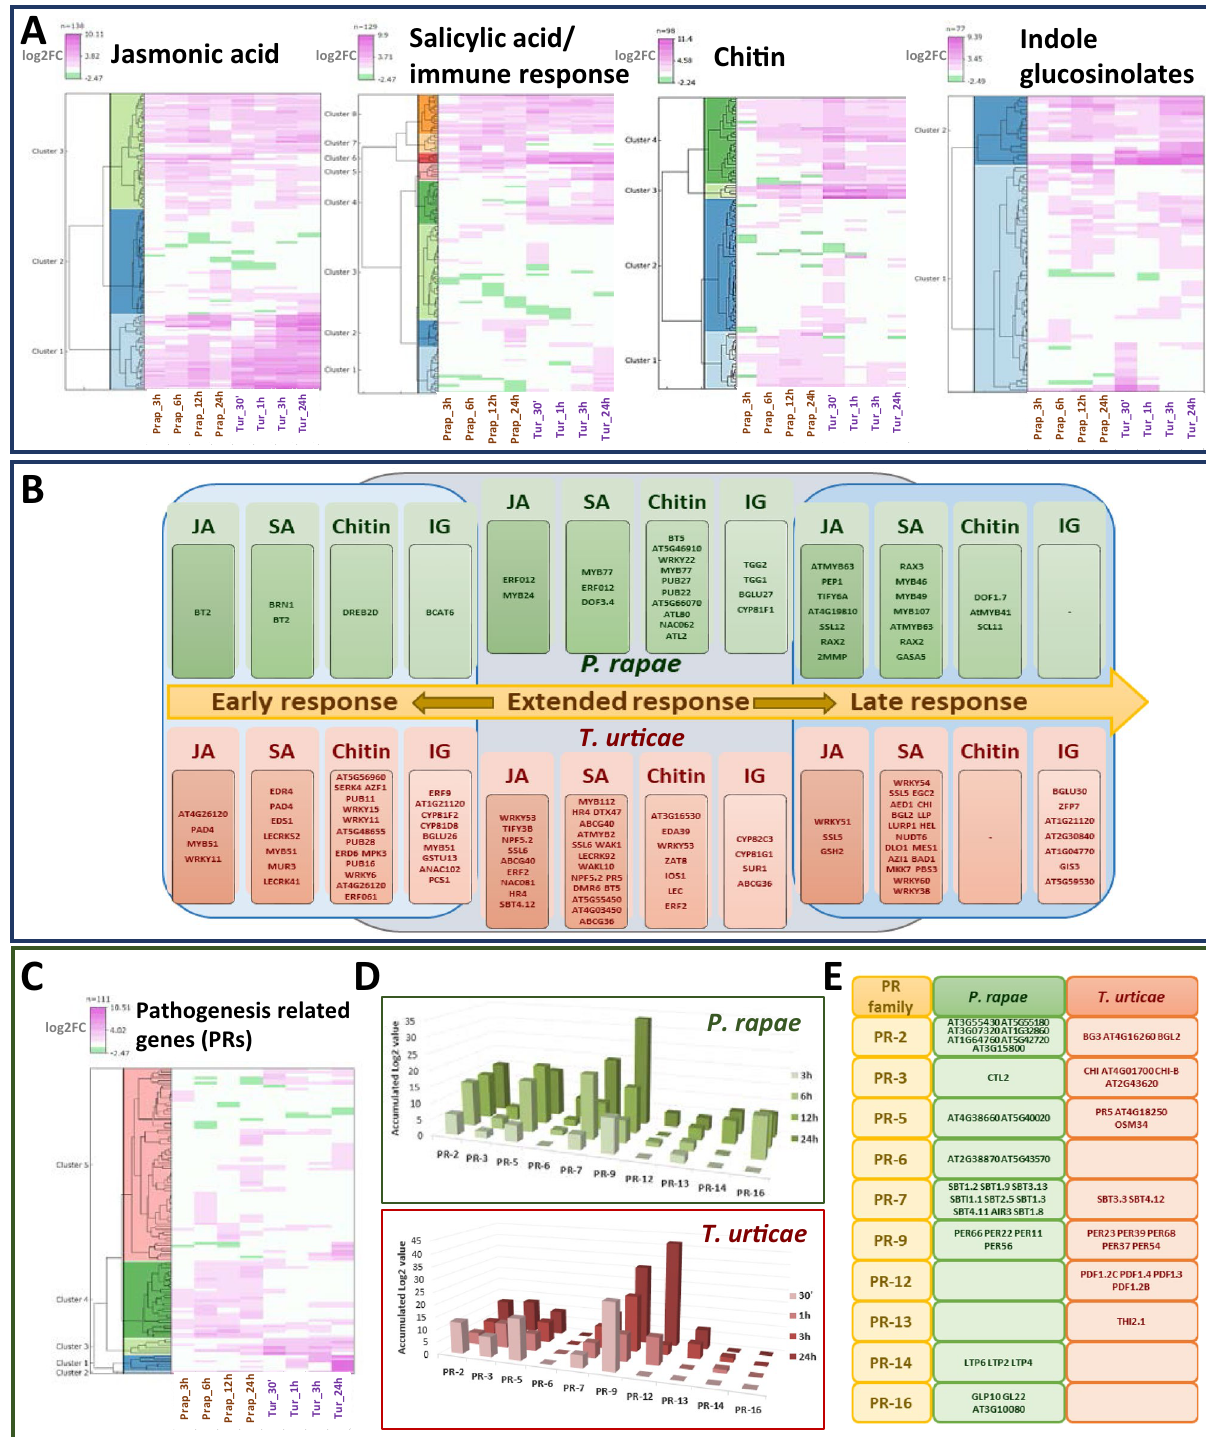
Figure 2. Comparison of the transcriptomics data at four time points of infestation by P. rapae or T. urticae . ( A ) Heatmaps showing the transcriptomic profile of the DEGs belonging to defence-related categories and detected at least in one experiment. ( B ) Schematic representation of the species-specific DEGs along plant response. ( C ) Heatmap showing the transcriptomic profile of the differentially expressed pathogenesis related genes detected at least in one experiment. ( D ) Accumulated expression of the DEGs from the PR categories at the different time points analysed. ( E ) Summary of the individual species-specific differentially expressed PR genes upon 24 h